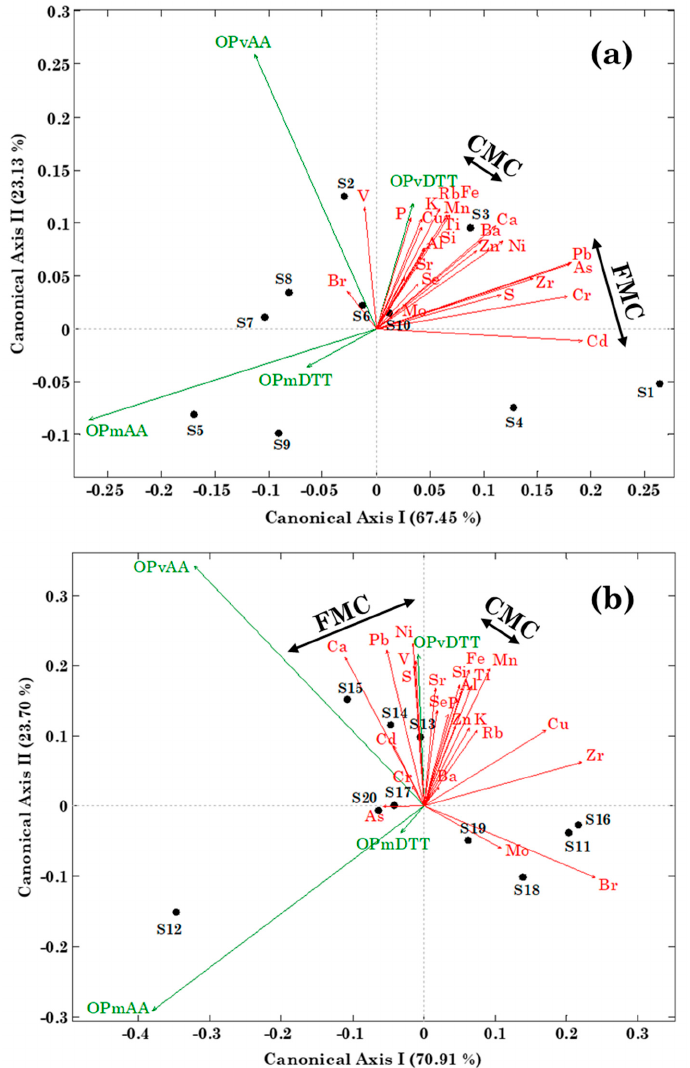
Figure 3. Ordination triplot based on the Redundancy Discriminant Analysis (RDA) between the mass concentrations of all analyzed chemical elements as predictive variables (red arrows), ascorbic acid and dithiothreitol volume-normalized oxidative potential (OP V AA and OP V DTT, respectively) and mass-normalized oxidative potential (OP m AA and OP m DTT, respectively) as response variables (green arrows), and detected samples (black full dots) in ( a ) winter and ( b ) spring. Black arrows indicate the two identified clusters (coarse-mode cluster (CMC) and fine-mode cluster (FMC)) based on the sources associated with the analyzed chemical elements. The total variance explained by the two RDA axes is also reported in